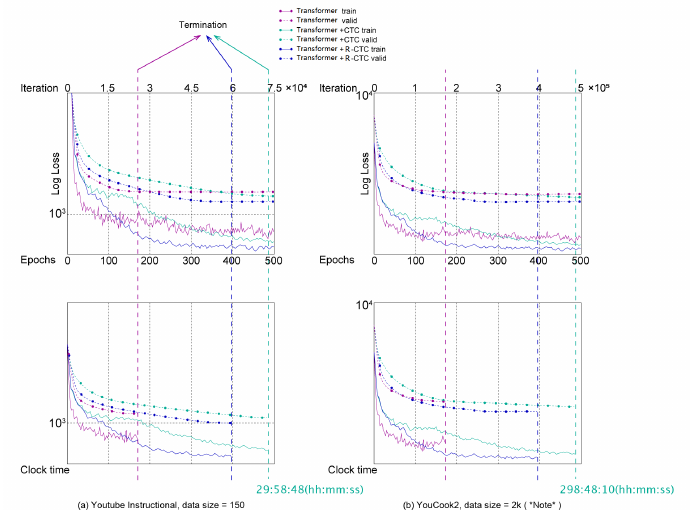
Figure 7. Loss curves in log-scale w.r.t. the number of epochs and elapsed clock time. Vertical dotted lines of different colors indicate that the loss function on the corresponding validation no longer dropped between two consecutive epochs, which is the position where the virtual learning process actually terminated. (Note: Due to time and hardware limitations, only a subset of ∼ 1 k samples were selected for cross-validation training on the YouCook2